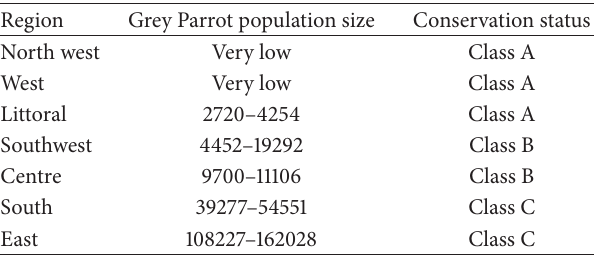
Table 4: Regional distribution of Grey Parrot population size and conservation